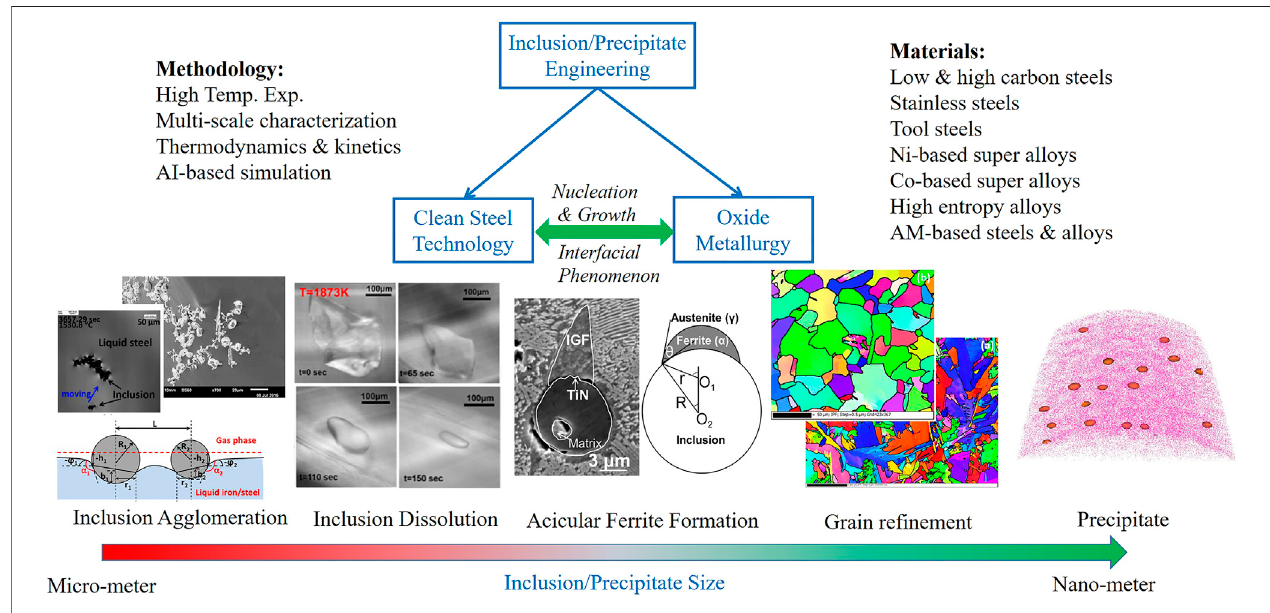
FIGURE 1 | Illustration of “ Inclusion/Precipitate Engineering ”